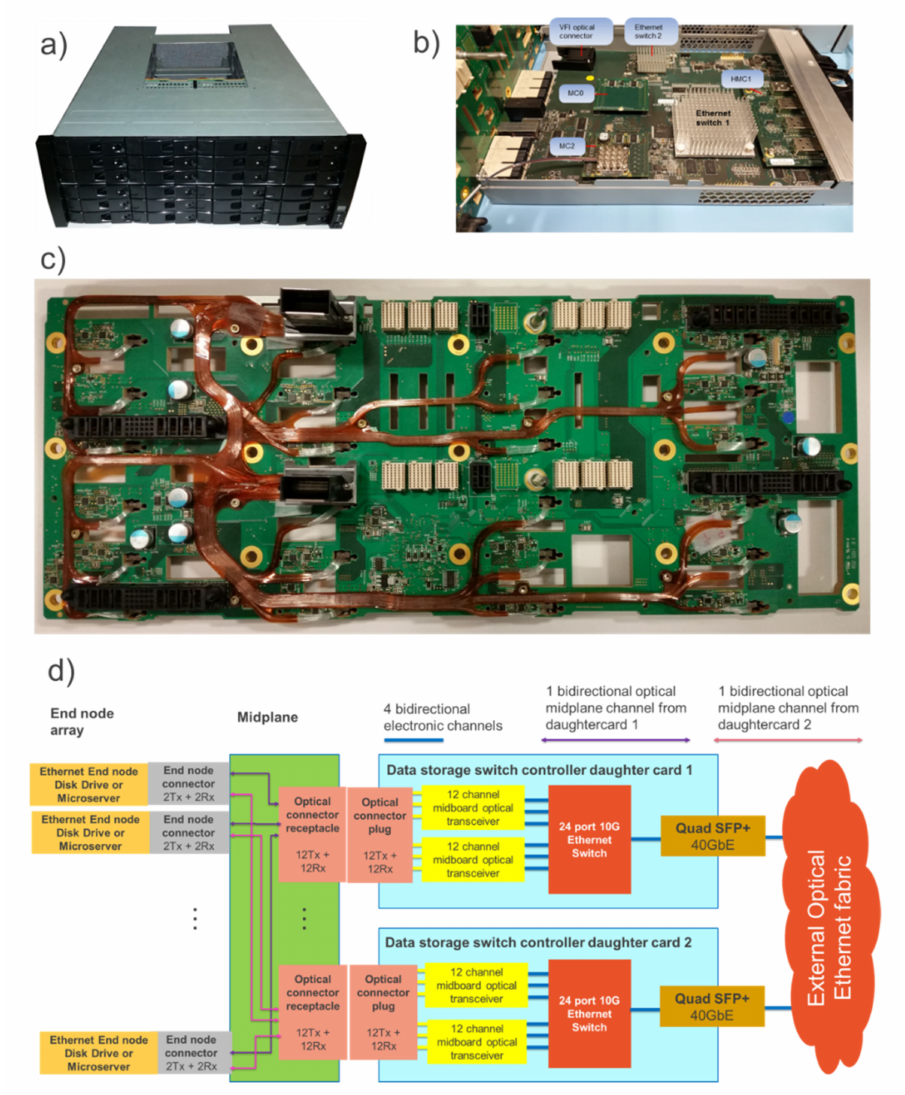
Figure 12. Pegasus—optically enabled, object-oriented converged switch, storage and compute platform: ( a ) photo of Pegasus system [8], ( b ) optically enabled controller card with mezzanine transceiver cards, ( c ) electro-optical midplane with 192-fiber flexplane [8], ( d ) schematic view of interconnect